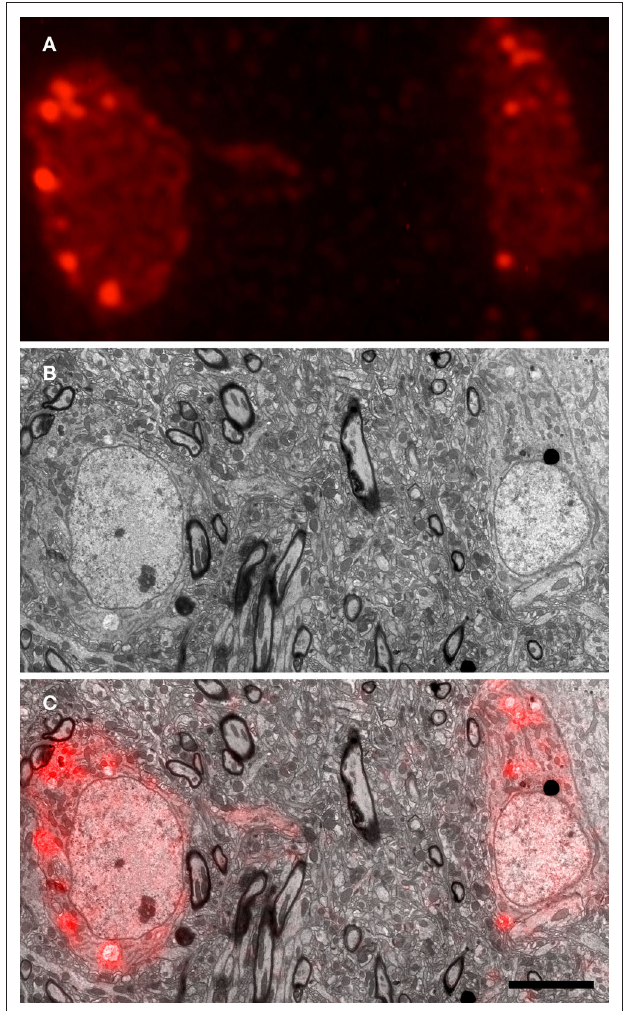
Figure 4 | Correlation of LM and eM images. (A) Light micrograph of the two cells immunostained for Lucifer yellow highlighted in Figure 3 . (B) The same region as in (A) is imaged in the TEM, revealing preservation of ultrastructure. (C) Immunofluorescence image superimposed on the TEM image. Scale bar: 5 μm.